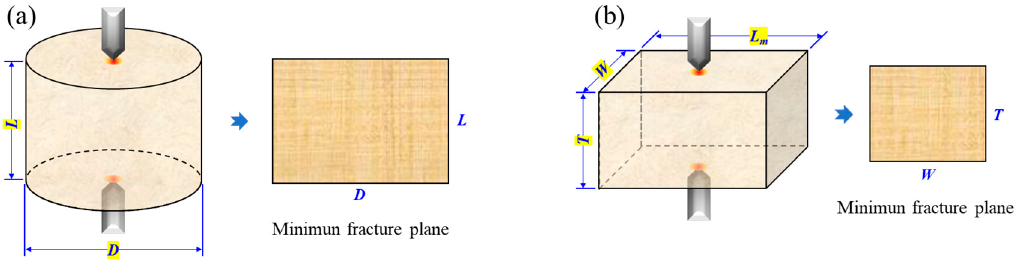
Figure 3. Schematics of the sample suggested in CPL testing: ( a ) cylindrical sample and ( b ) block sample (modi fi ed from [31]).